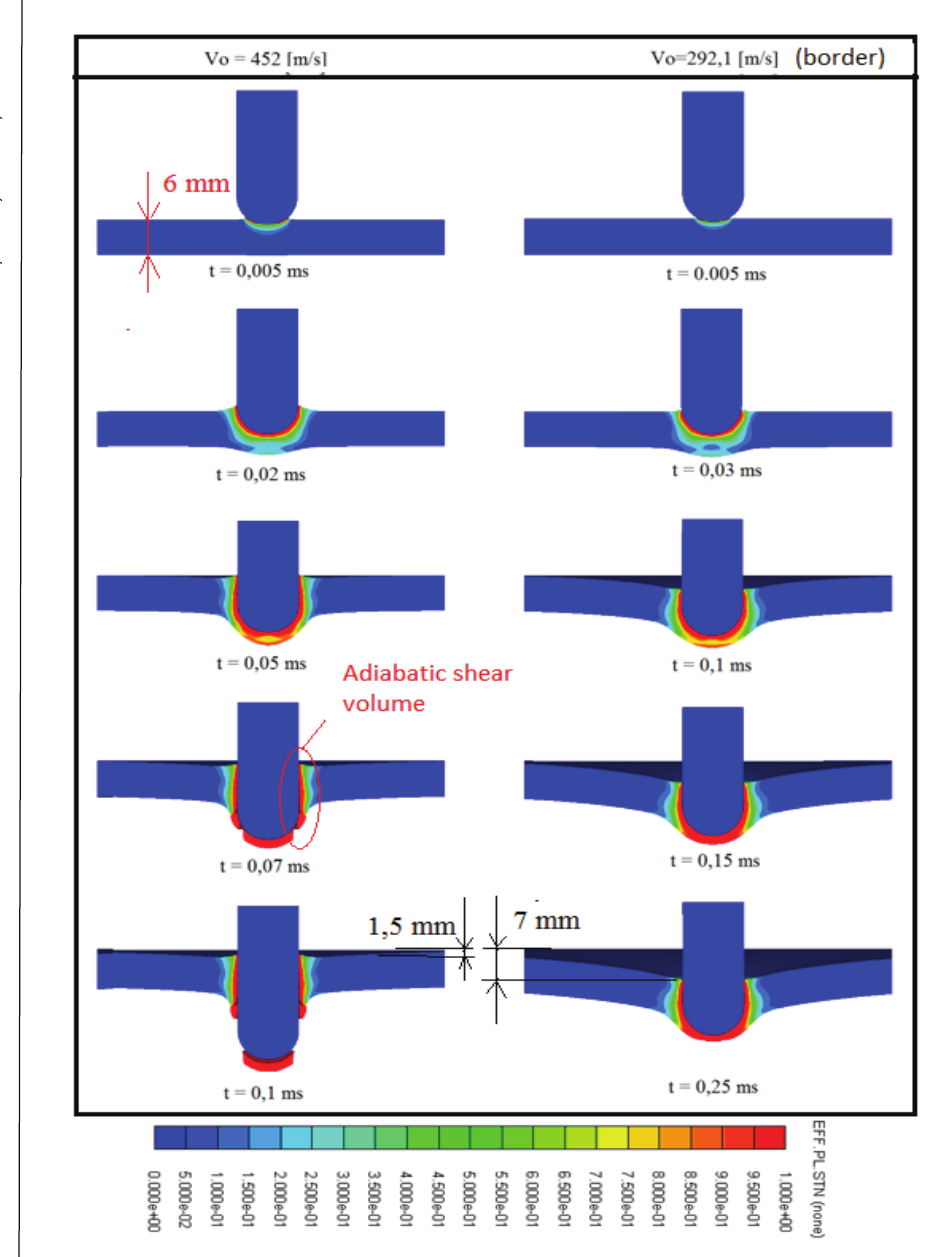
Figure 38 – Comparative illustration of steel plate penetration by two-speed hemispherical projectiles, FEM